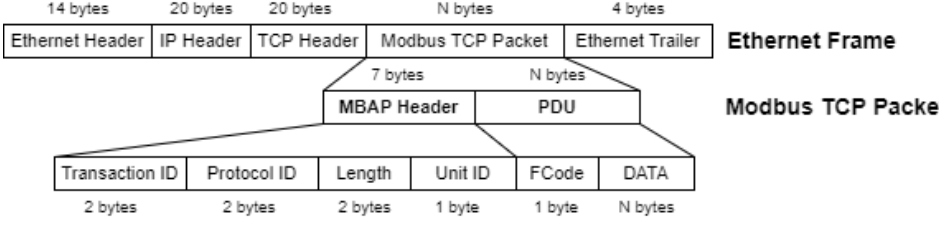
Figure 4. Modbus TCP packet